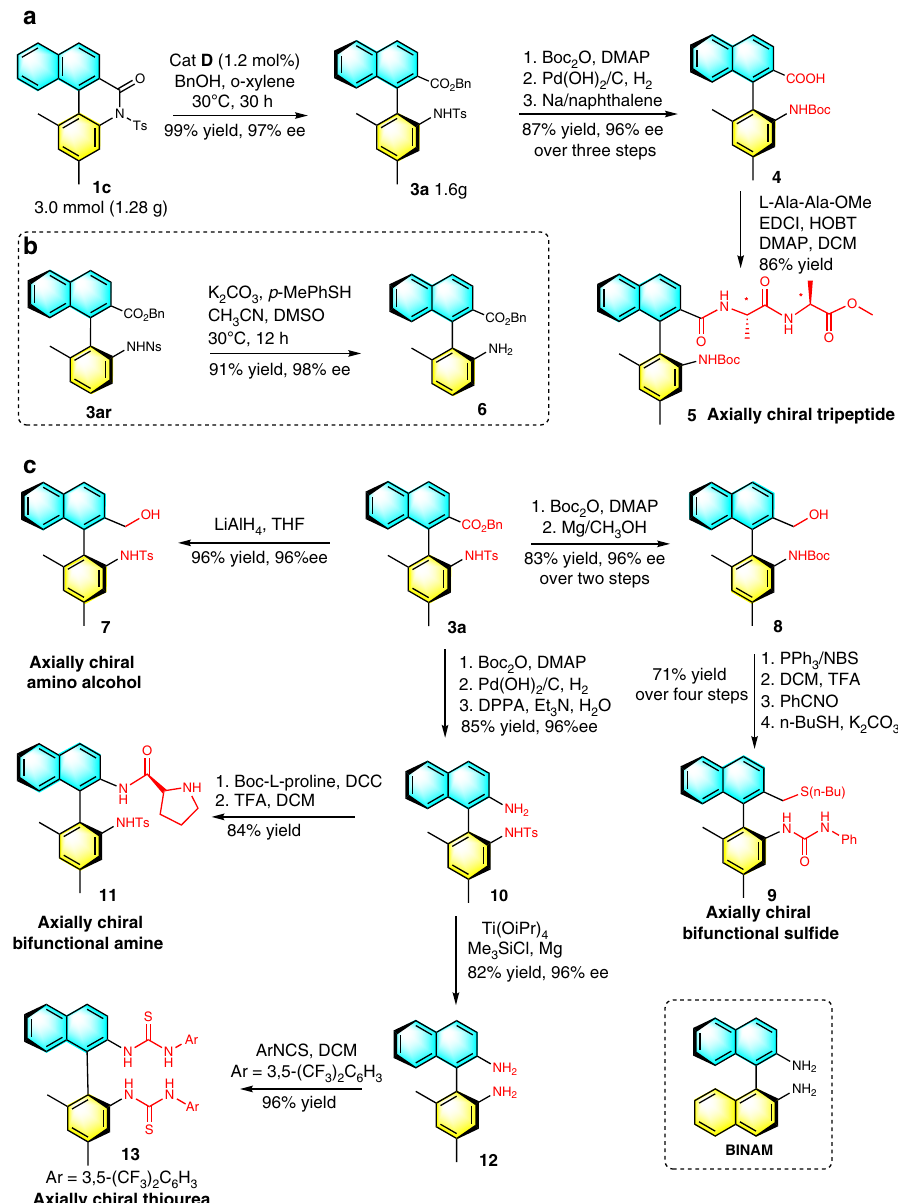
Fig. 5 Synthetic transformations. a Gram-scale reaction, synthesis of N -Boc axially chiral biaryl amino acid, and tripeptide. b Synthesis of unprotected axially chiral biaryl amino esters. c Synthesis of axially chiral